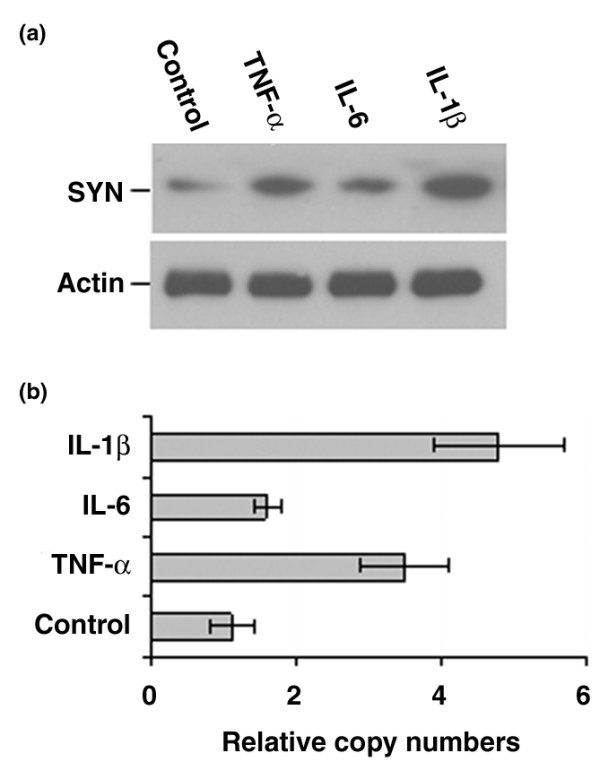
Induction of Synoviolin (SYN) expression by proinflammatory cytokines. (a) Mouse synovial fibroblasts were starved for 24 hours and then cultivated for 48 hours with each proinflammatory cytokine, including 10 ng/ml of tumor necrosis factor-α (TNF-α), interleukin (IL)-1β, or IL-6. The expression of SYN was tested by Western blotting by using anti-SYN antibody (top panel). As a control, the protein level of actin was detected using the same membrane (bottom panel). (b) The total RNA from the cultured synovial fibroblasts was isolated and reverse-transcribed into cDNA. The levels of SYN cDNA were analyzed by real-time polymerase chain reaction by using SYN-specific primers. Error bars represent the results from three independent experiments (mean ± standard deviation).